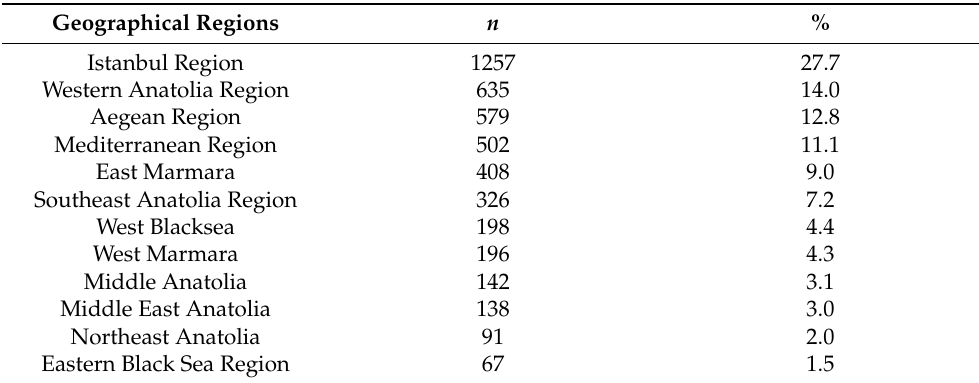
Table 1. Distribution of participants according to geographical regions of